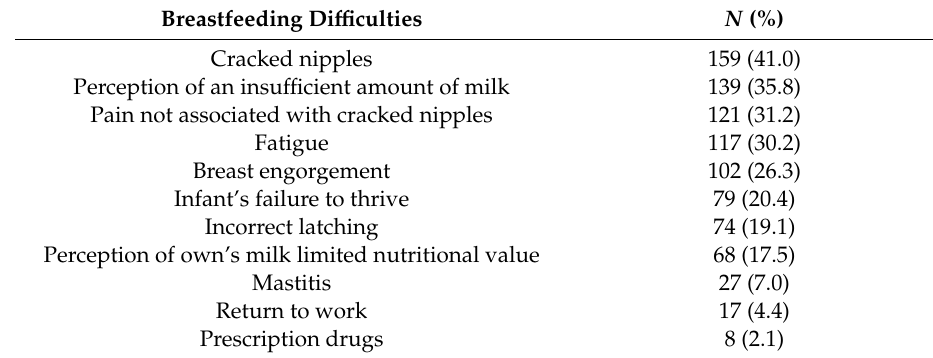
Table 3. Breastfeeding di ffi culties arisen at any time point of the study according to mothers’